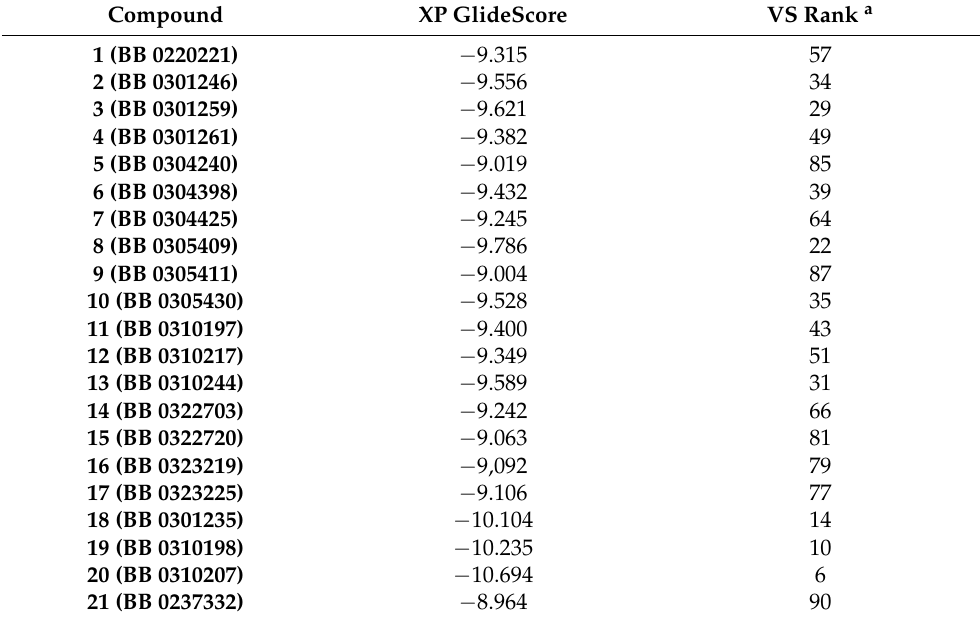
Table 1. Compounds selected for experimental